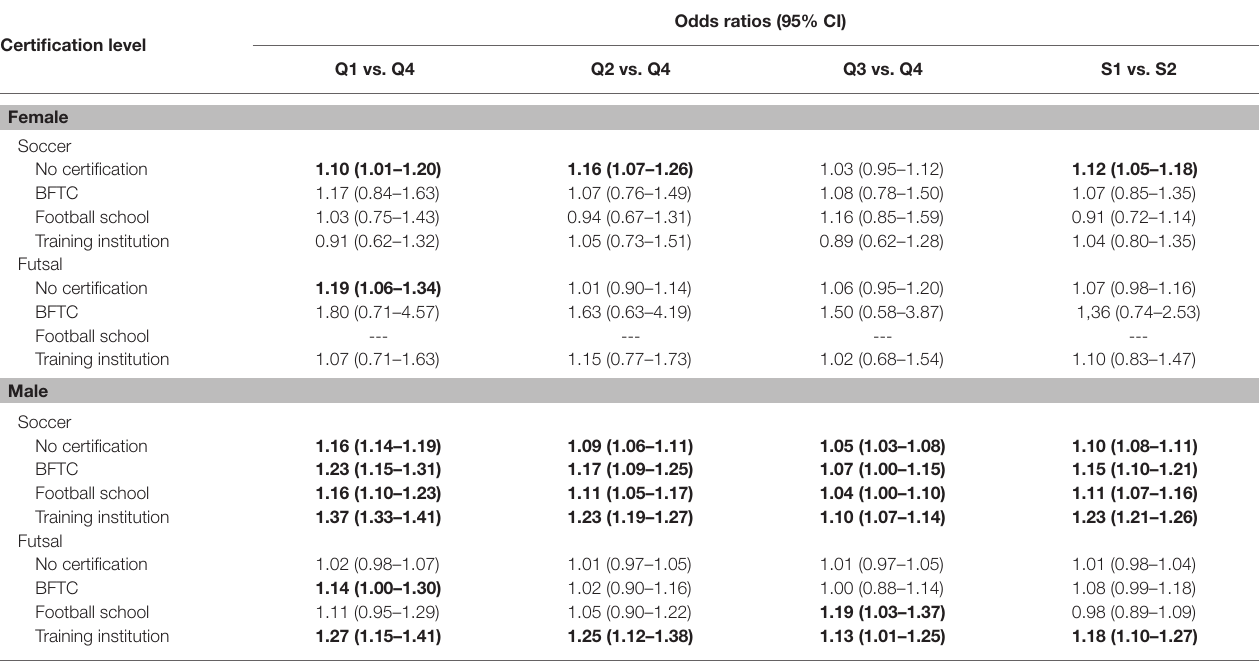
TABLE 4 | Odds ratios (95% CI) by gender and certification level (according to the certification of clubs and academies as classified by the Portuguese Football Association.) for youth soccer and futsal players examining RAE.